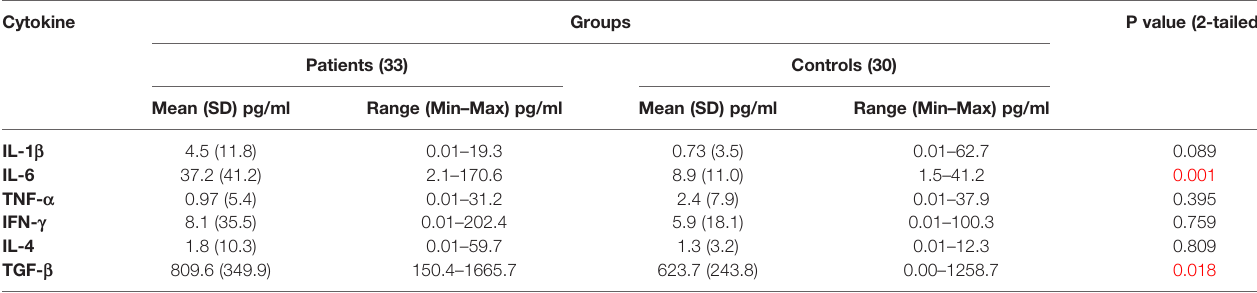
TABLE 3 | Cytokine results in patients and control groups. Cytokine